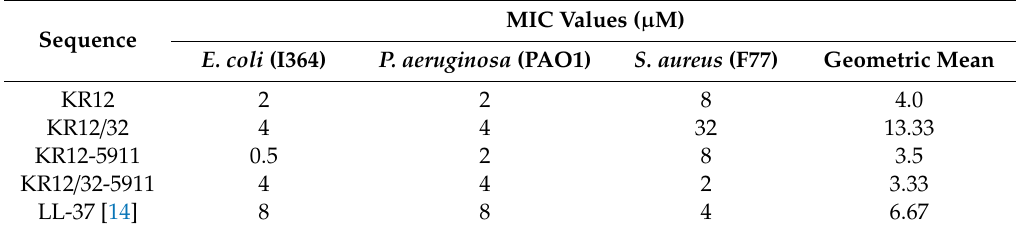
Figure 1. Minimum inhibitory concentration (MIC) values for the designed KR12 analogues. Table 3. MIC values for the designed KR12 analogues compared to the LL-37 human cathelicidin.